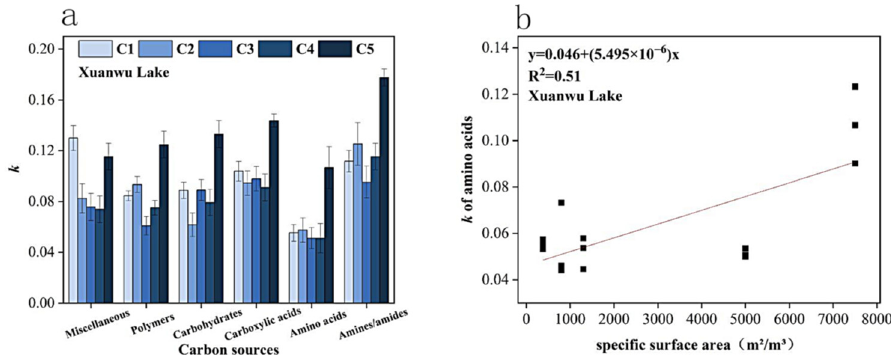
Figure 5. The carbon metabolism rate of biofilm attached to five carriers with different specific surface areas (C1–C5) in Xuanwu Lake ( a ), and the fitting curve between carbon metabolism rate of amino acids and carriers’ specific surface area in this lake ( b ).